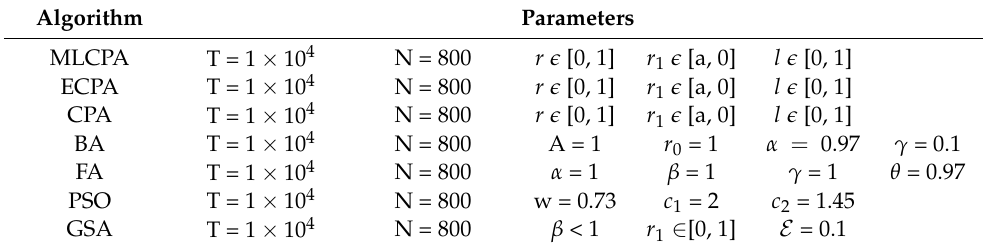
Table 1. Parameters